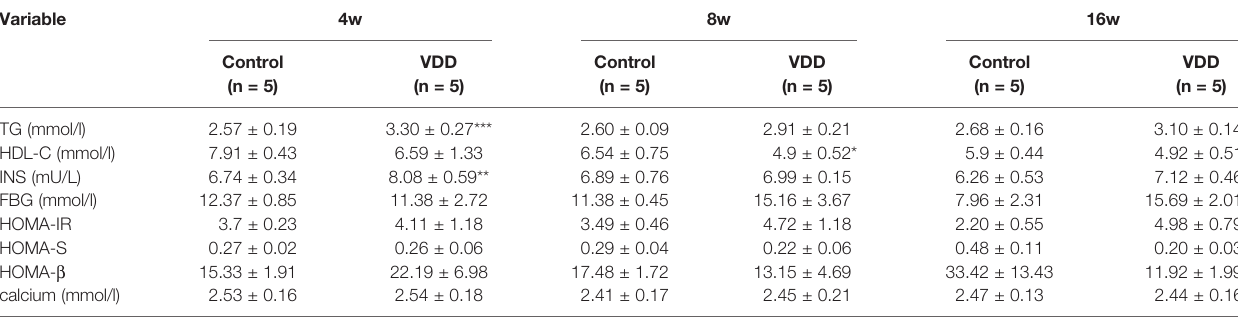
TABLE 1 | Fasting variables of the control and VDD group of offspring at different time points. Variable 4w